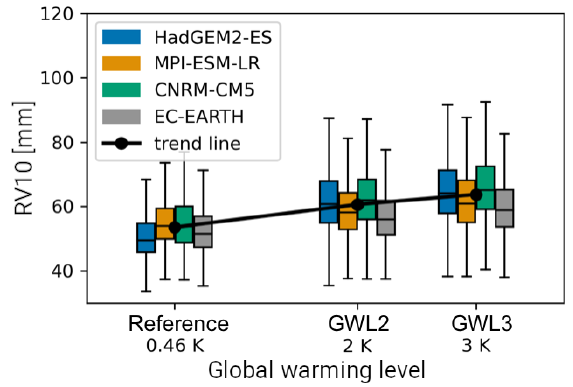
Figure 11. Box plots of spatially averaged RL10 distributions over CReg for the reference period, GWL2, and GWL3 for all ensemble members of KIT-KLIWA. The boxes represent the lower and upper quartiles, the center lines the median, and the whiskers the outliers, defined as more than 1.5 times the interquartile range. Black dots and line show the multi-model ensemble mean for each set of runs and the trend.